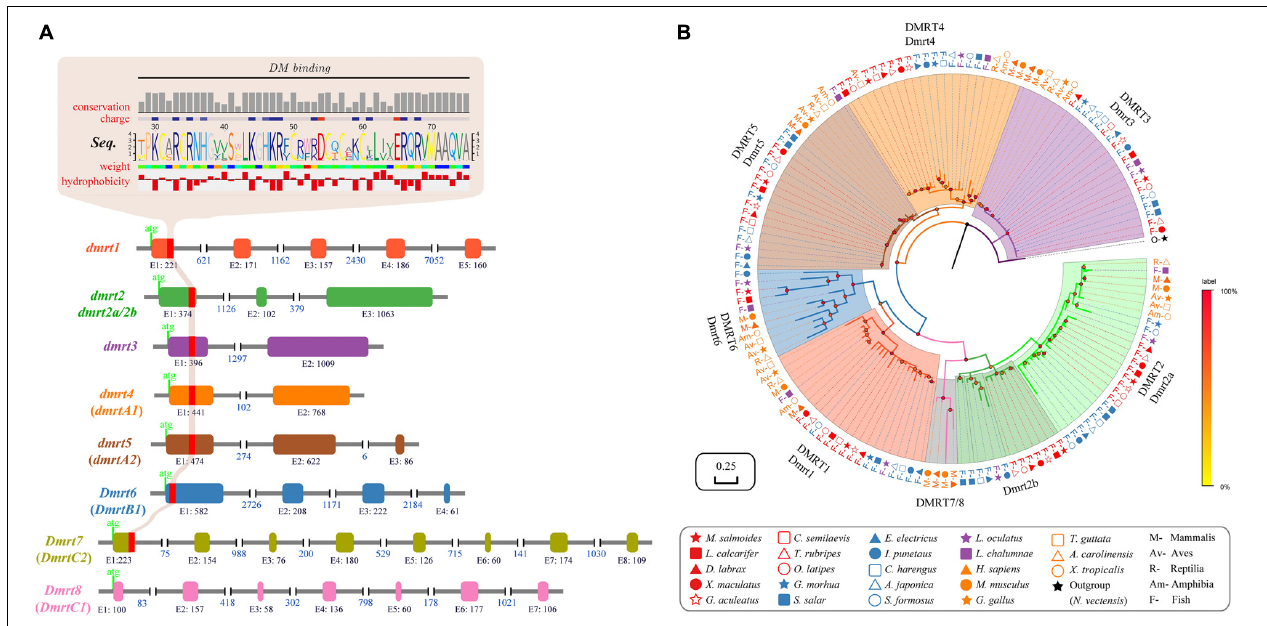
FIGURE 1 | Characterization and phylogenetic analysis of the dmrt family in vertebrates. (A) Various structures of dmrt genes. The genomic structures of dmrt1–dmrt5 are based on the data of Japanese pufferfish, whereas those of dmrt6–dmrt8 are derived from the relevant data of mouse. (B) A Bayesian phylogenetic tree of 147 dmrt sequences. The phylogenetic analysis was performed using MrBayes v3.2.6. Amino acid replacement model selection was calculated using ProtTest with the best-fit model of JTT+I+G+F. The tree is rooted with the N. vectensis dmrtA